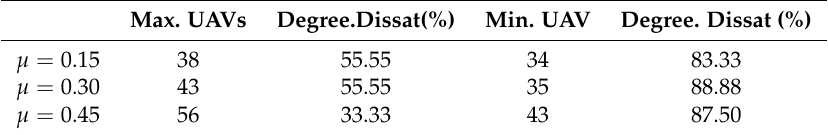
Table 6. Maximum and minimum No. of UAVs for each